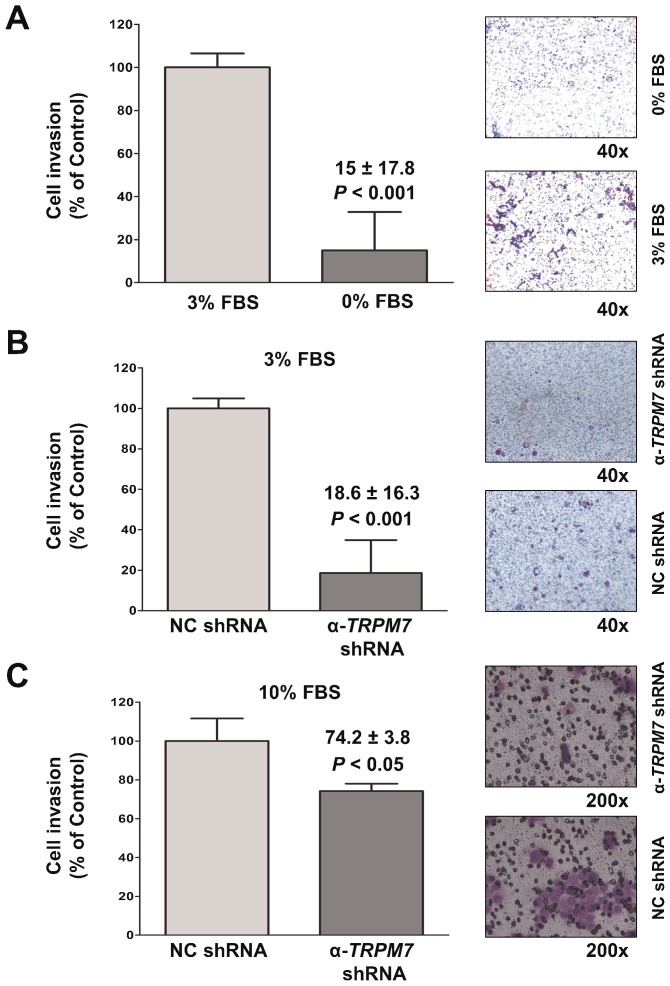
ShRNA-mediated silencing of TRPM7 impaired invasion in pancreatic adenocarcinoma cells.(A) Non-transfected BxPC-3 cells assayed for invasion using the trans-well assay in the presence of 3% FBS or no FBS. (B,C) BxPC-3 cells transfected with non-targeting control (NC) shRNA or anti-TRPM7 shRNA analyzed for cell invasion in the presence of either 3% FBS (B) or 10% FBS (C). A representative image of the invaded cells stained with crystal violet is shown for each experimental group. Cell invasion is expressed as % control, and each column represents the mean ± standard error.